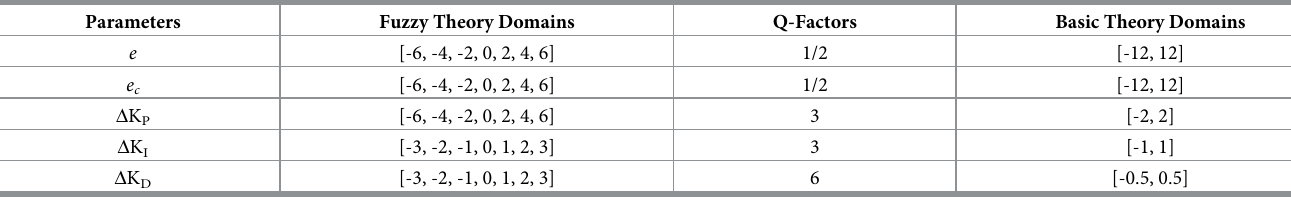
Table 1. Fuzzy theory and quantitative factors of rectifying